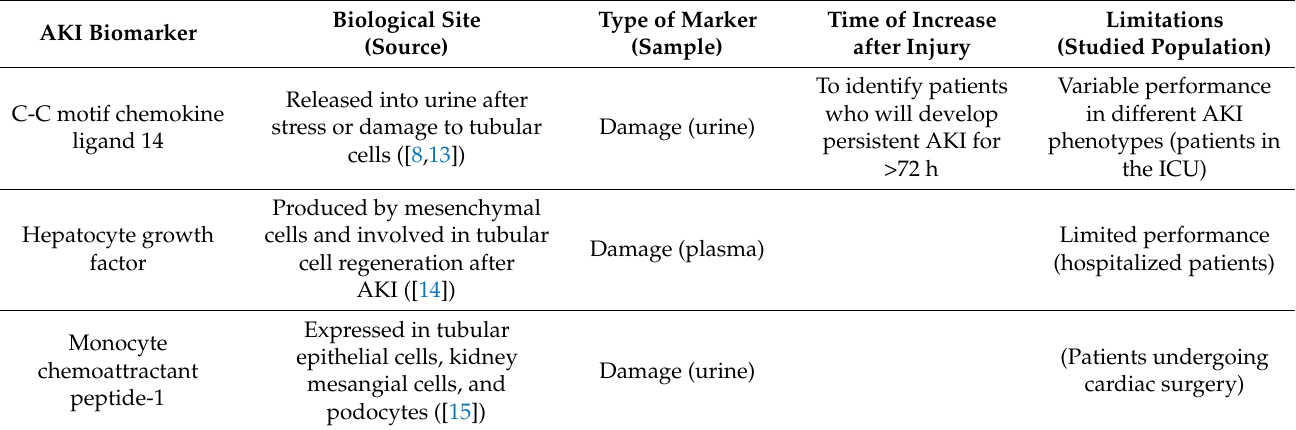
Table 2. Biomarkers of AKI progression and reversal (adapted from